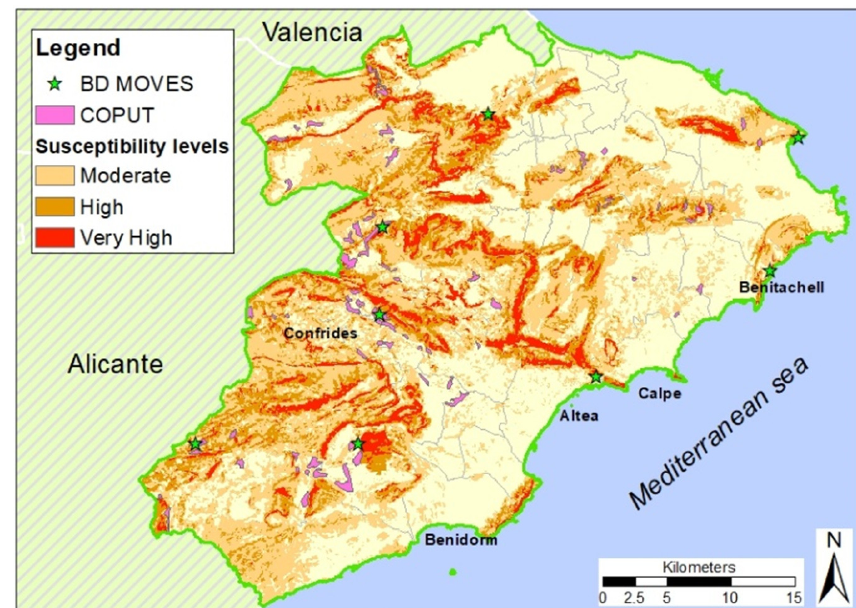
Figure 4. La Marina area. Susceptibility, landslides location and areas with instabilities.